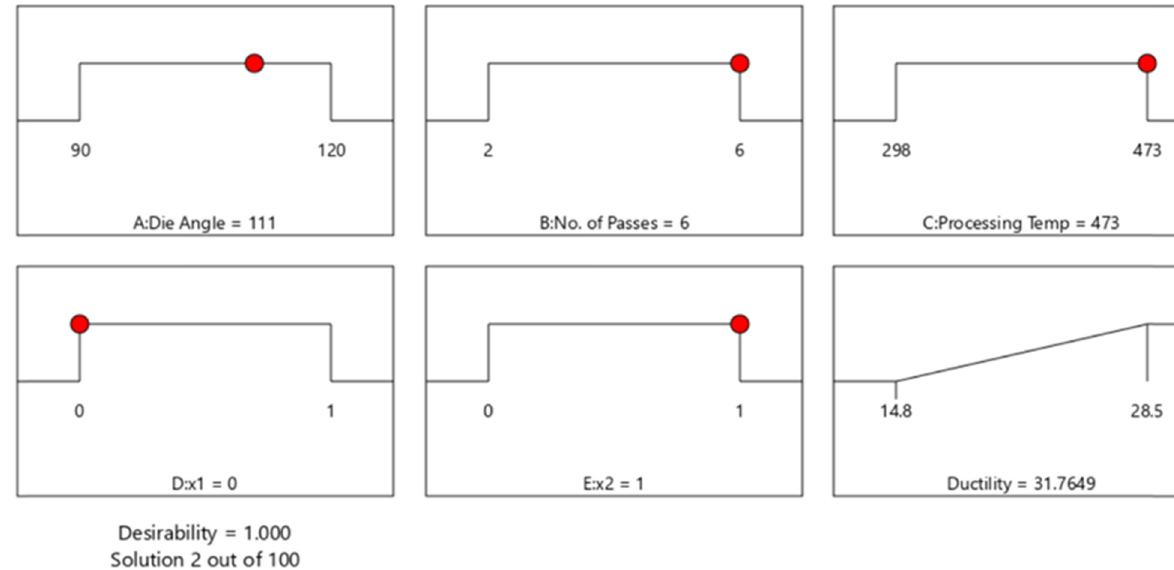
Figure 21: RSM optimization results of D u .